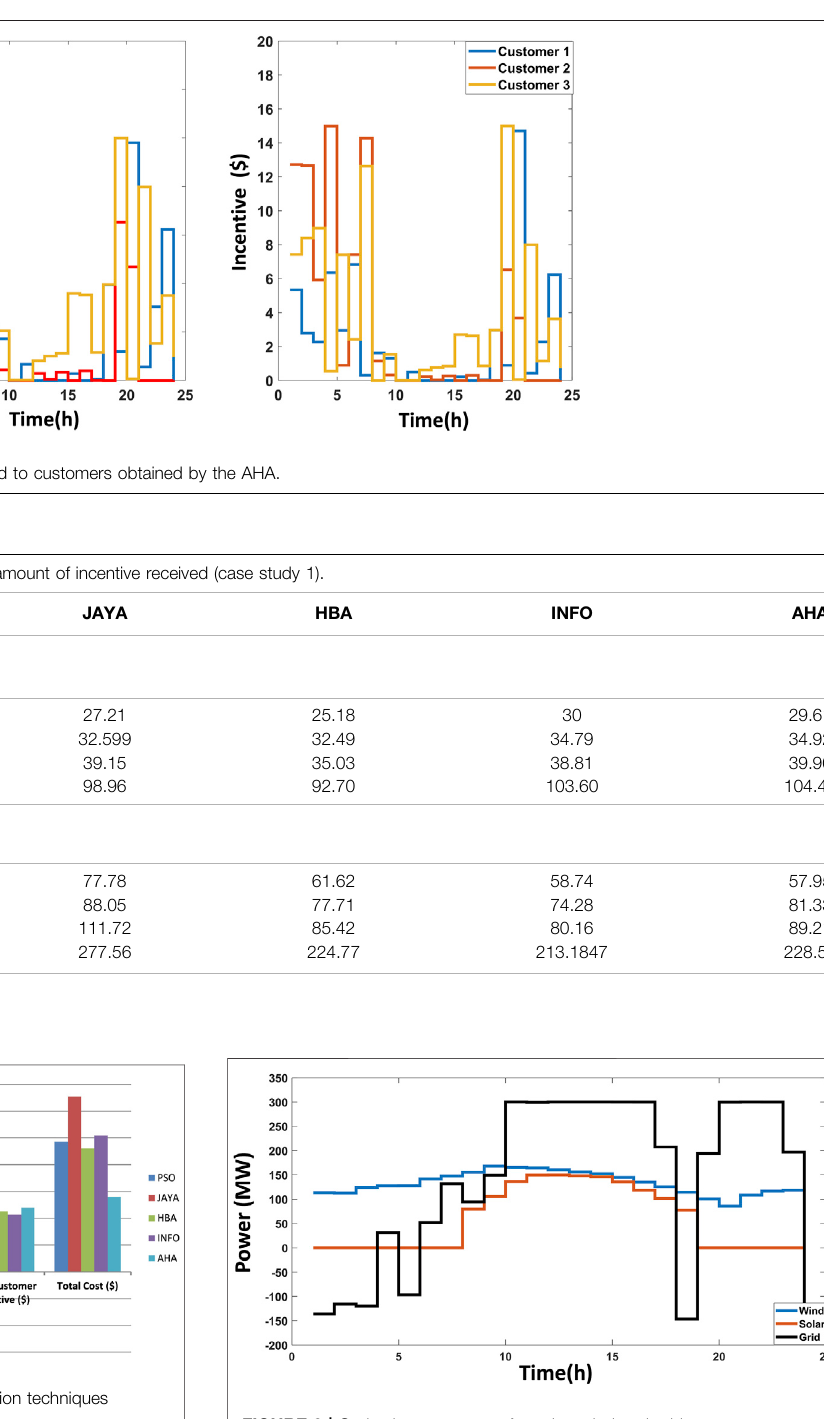
Frontiers in Energy Research |